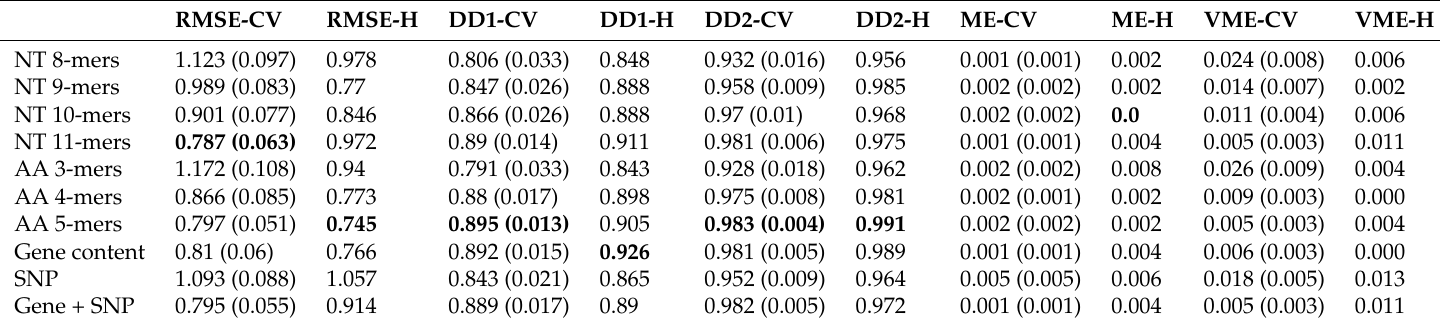
Table A58. S. enterica